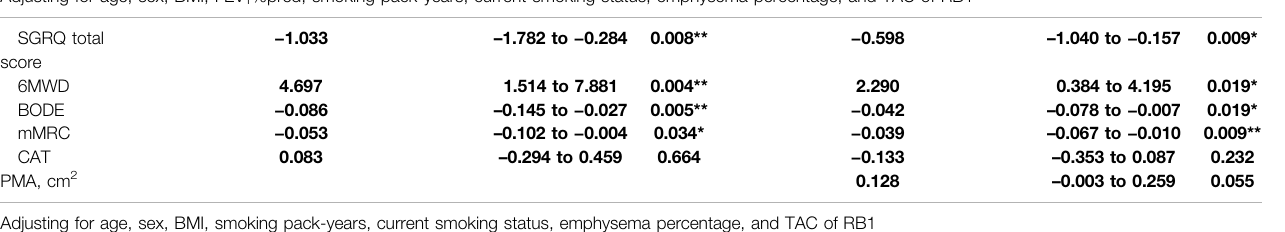
TABLE 5 | The baseline characteristics of patients with stable COPD when the BMI classi fi cation was carried out. Low ( < 18.5 kg/m 2 )